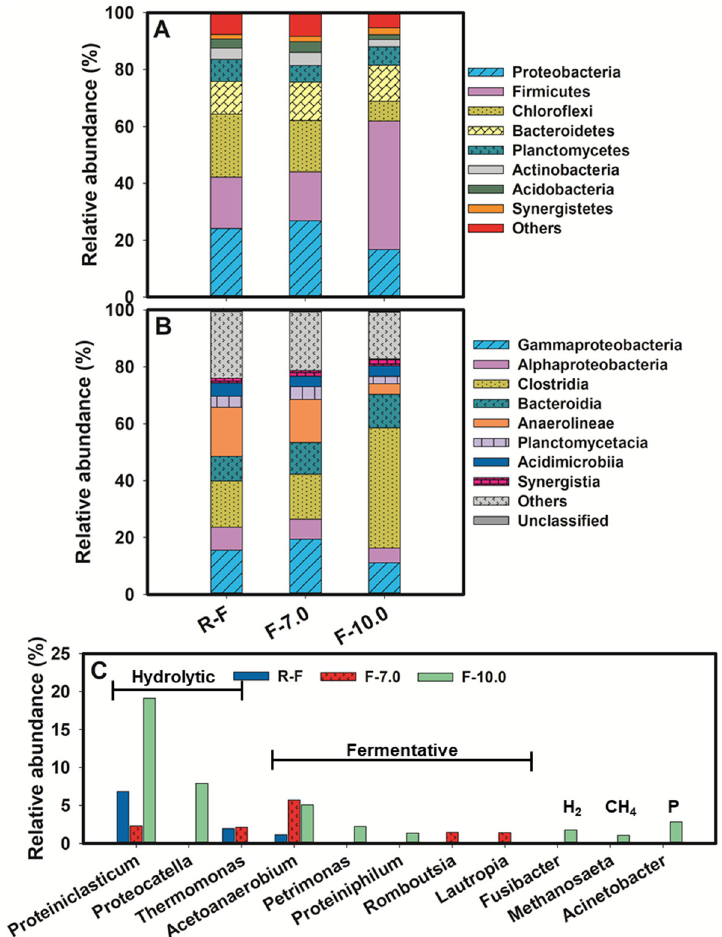
Figure 4. Taxonomic classification of pyrosequences from bacterial communities of sludge samples, ( A ) for bacterial community at phylum level, ( B ) for bacterial community at class level, ( C ) for bacterial community at genus level.